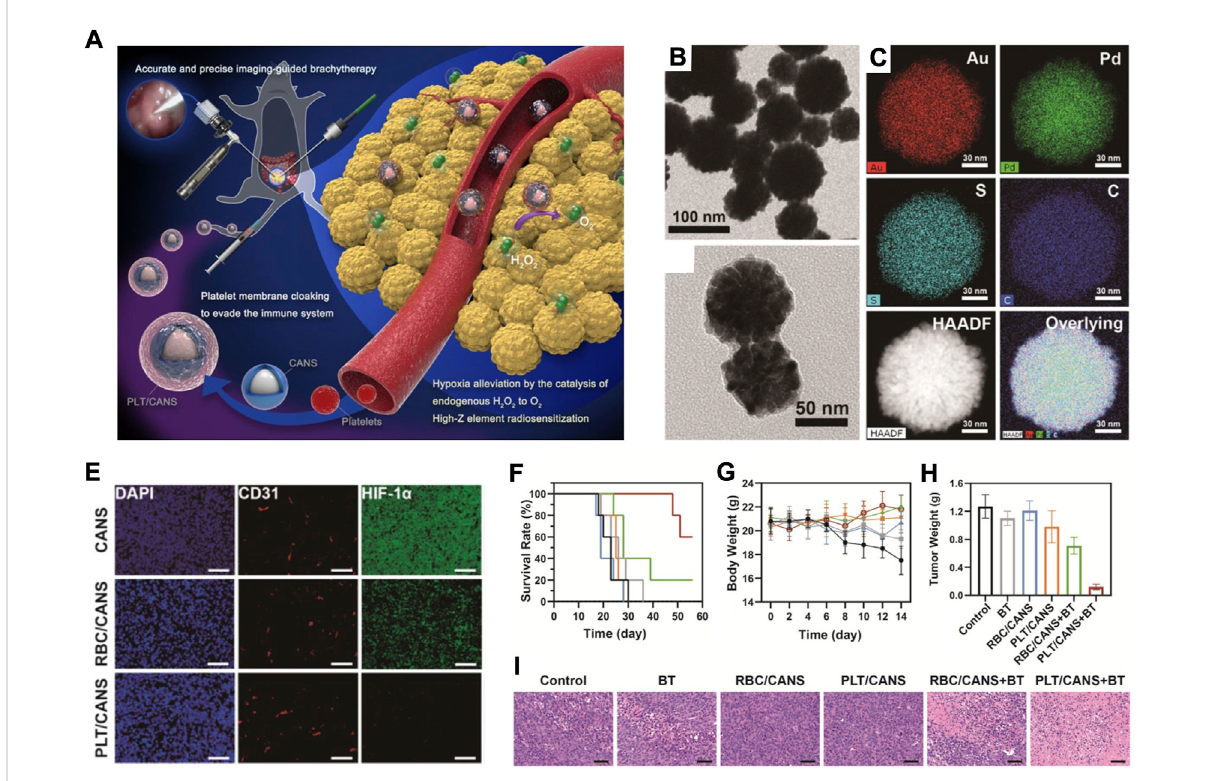
FIGURE 6 (A) TheschemeshowingthepreparationofPLT/CANSanditsapplicationinalleviatingtumorhypoxia. (B) TEMimageofCANS. (C,D) TEMimage (C) and (D) elementmappingimageofPLT/CANS. (E) Immuno fl uorescenceanalysisoftumorsectionsstainedwithTUNELandHIF-1 α afterindicated treatments (scalebars:50 μ m). (F – H) Survivalrates (F) ;bodyweights (G) andtumor masses (H) ofmiceafter indicatedtreatments. (I) H&E